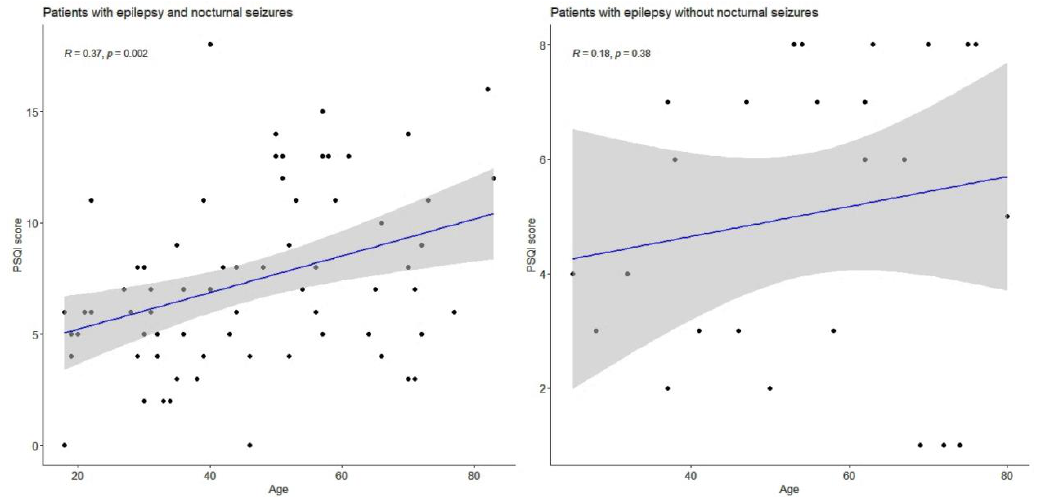
Figure 2. Correlation between PSQI score in relation to patients’ age in the experimental group versus control group; Spearman’s correlation.